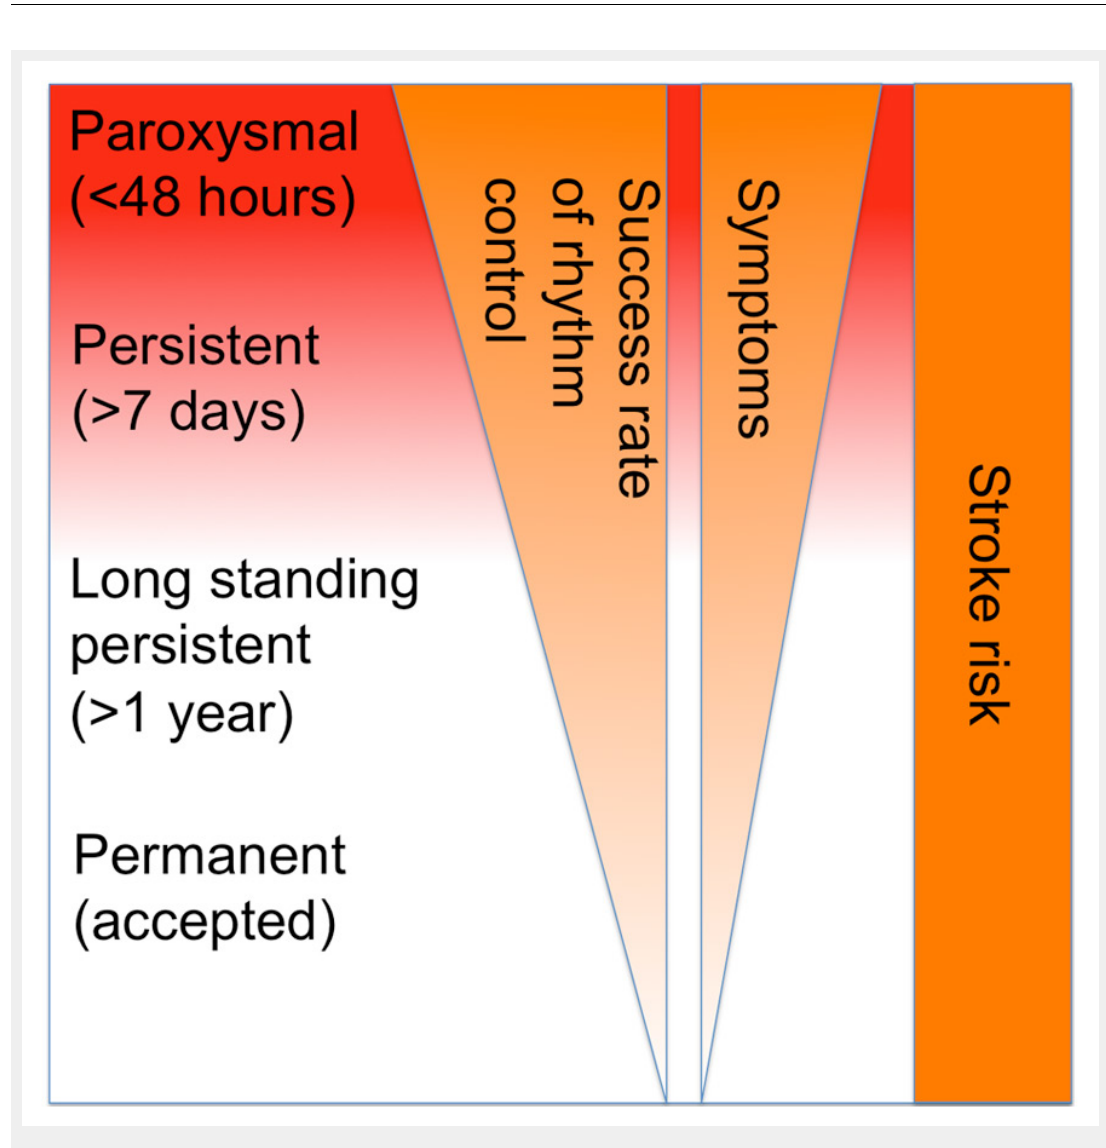
Time course of atrial fibrillation. AF may progress from paroxysmal to permanent. The success rate of rhythm control strategies (drugs and intervention) decreases and, although there is a broad variation, patients tend to be less symptomatic. It is of paramount importance to recognise that the risk of stroke is similar for patients, independent of their type of AF. While diagnosis of AF is trivial in patients with persistent AF, the search for AF in paroxysmal AF patients can consume significant resources. Nevertheless, the effort to detect AF should be taken in these patients with the goal to offer them adequate protection against thromboembolic